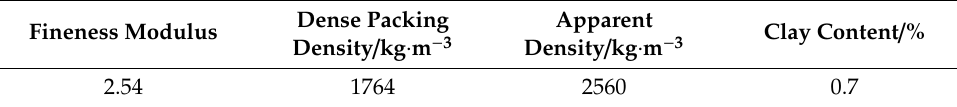
Table 2. The properties of fine aggregate.